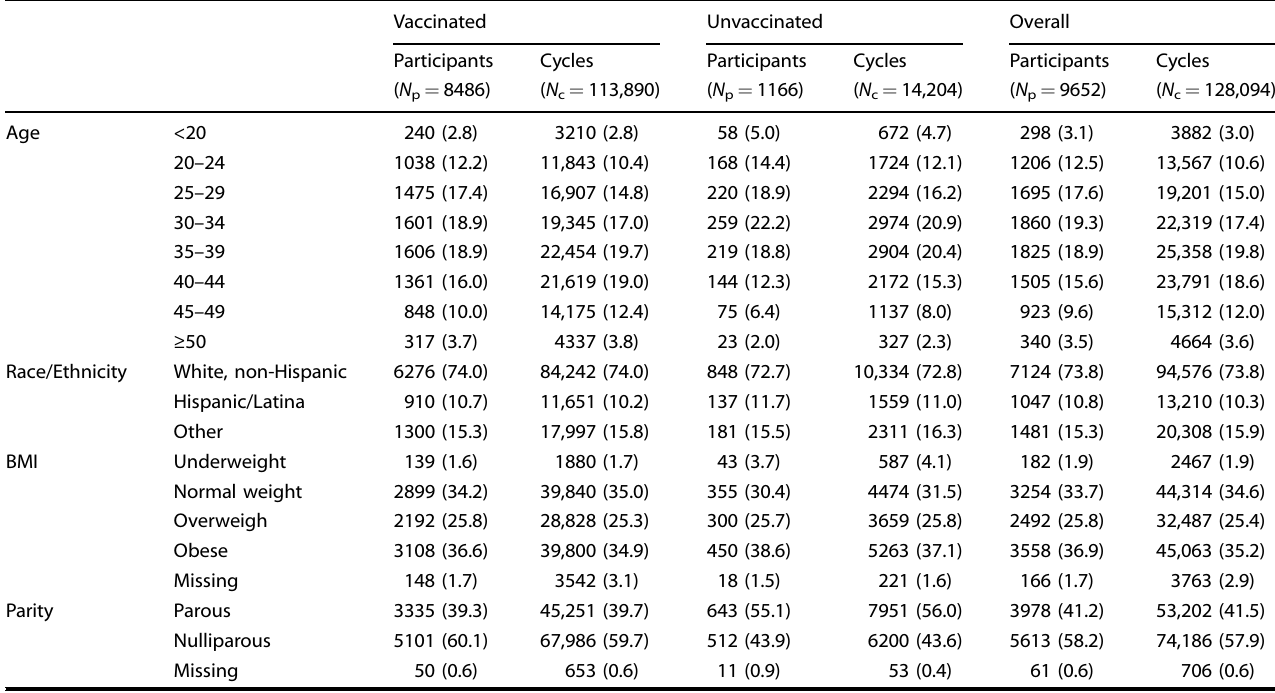
Table 1. Demographic characteristics among 9652 participants in the Apple Women ’ s Health Study at enrollment and number of cycles included among 128,094 total cycles.